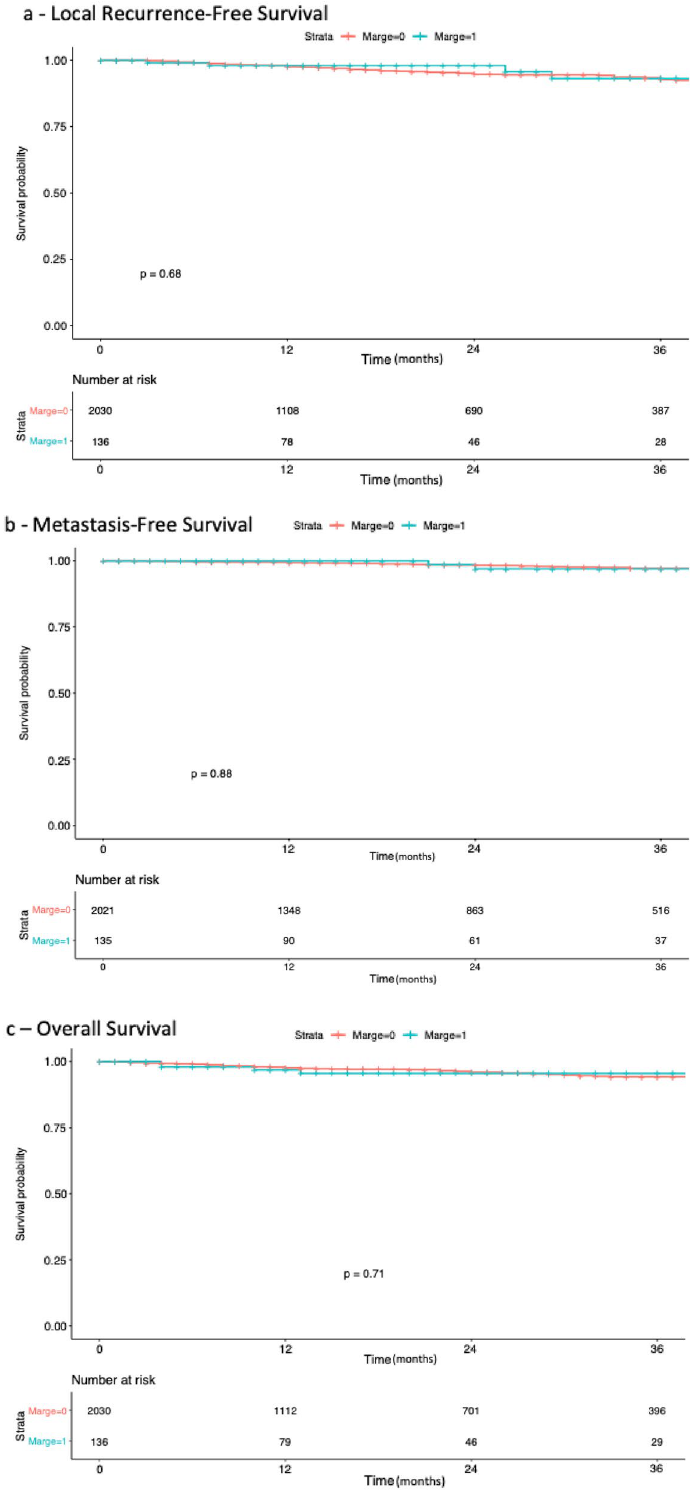
Figure 2. Kaplan–Meier survival curves after RAPN according to surgical margin. ( a ) Local Recurrence-Free Survival, ( b ) Metastasis-Free Survival, ( c ) Overall Survival. No statistical difference was made between